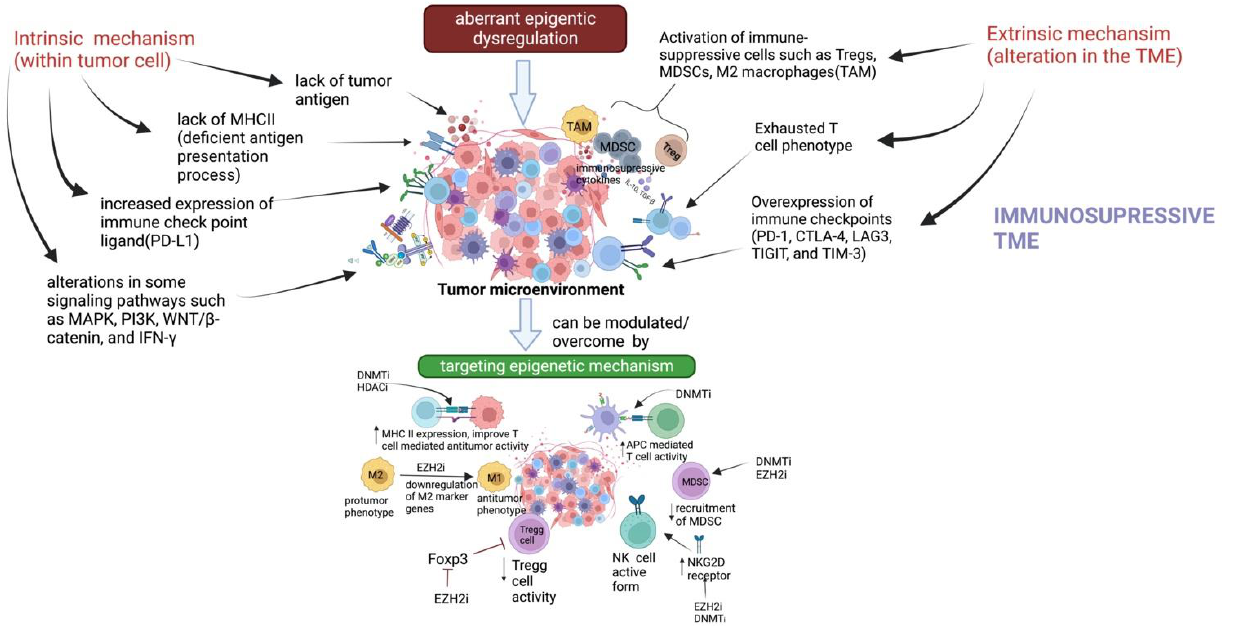
Figure 1. Mechanism of resistance to immunotherapy and combinational approach with epigenetics to improve immunotherapy efficacy: The efficacy of immunotherapy depends on T cell status. The intrinsic mechanism responsible for immunotherapy resistance involves lack of tumor antigen, increase expression of immune checkpoints, lack of MHCII complex, and alteration in signaling pathway; whereas, extrinsic mechanism develops due to alteration in the TME and includes activation of immunosuppressive cells (such as Tregs, MDSCs, M2 macrophage (TAMs) creating an immunosuppressive TME. Aberrant transcriptional programs responsible for cancer initiation and progression are driven by epigenome dysregulation. These epigenomic changes have also been found to modulate tumor immunogenicity and immune cells that participate in antitumor immunity. Hence, targeting epigenetic mechanisms may overcome immunotherapy